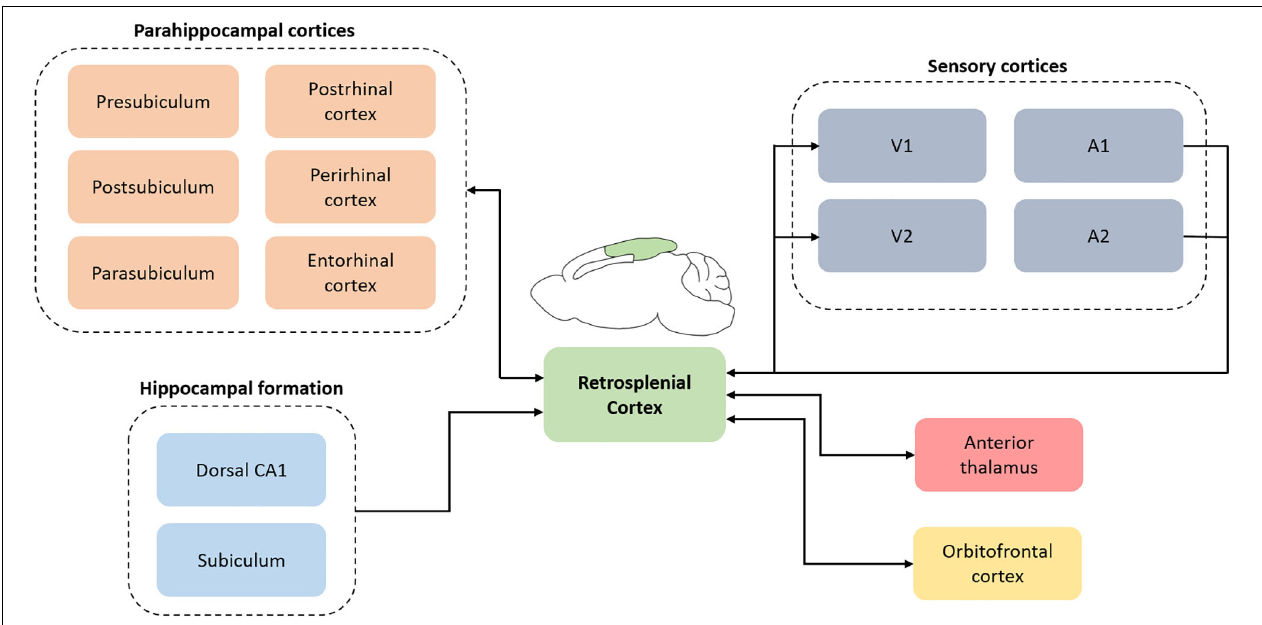
FIGURE 2 | A simplified schematic depicting retrosplenial connections with cortical and subcortical regions. The connectomic diagram is centered around retrosplenial cortex and does not include the complex interactions between all regions. V1, primary visual cortex; V2, secondary visual cortex; A1, primary auditory cortex; A2, secondary auditory